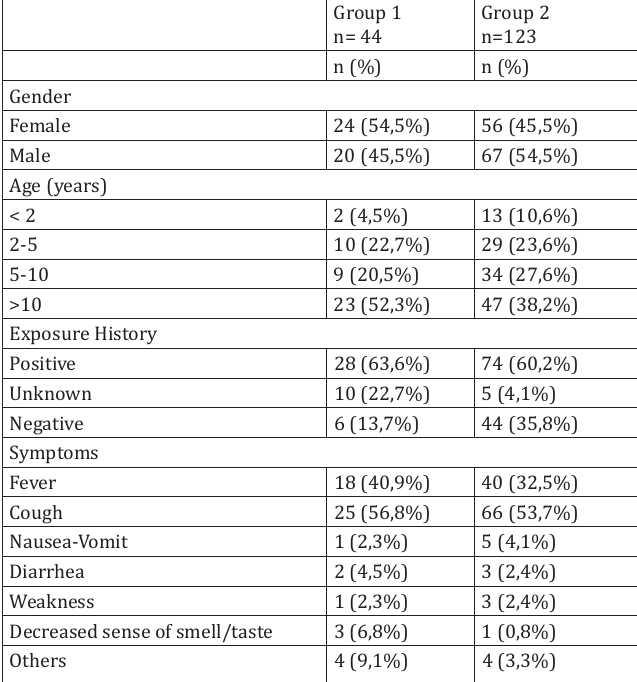
Patient characteristics and